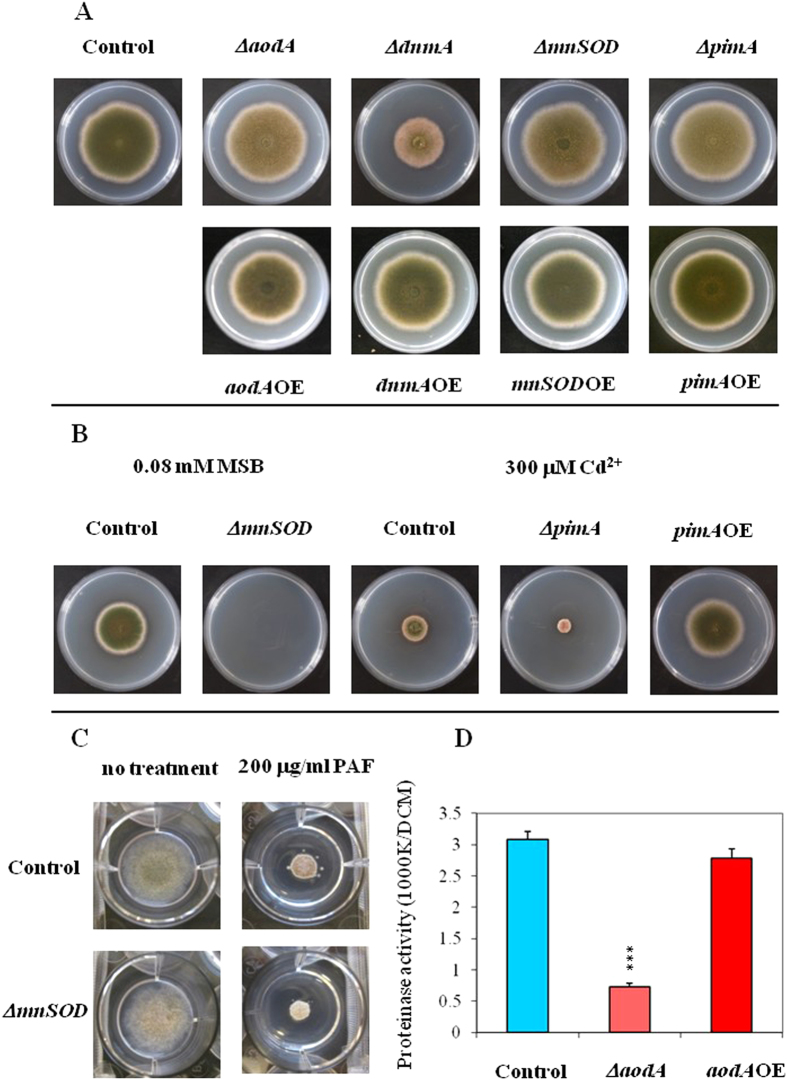
Comparison of the growth, stress sensitivities, cell death and autolysis of the control and mutant strains.Part A: Growth of control (THS30.3) and mutant strains on MNM agar plates. Part B: Selected stress sensitivity experiments with the control and the ΔmnSOD, ΔpimA and pimAOE strains. Part C: Growth inhibiting effect of the apoptosis-inducing antifungal protein PAF on the ΔmnSOD mutant in comparison to the control strain. Part D: Proteinase activities as autolysis markers2930 recorded in carbon-starving (24 h) submerged cultures of the THS30.3 control and ΔaodA and aodAOE mutants. In proteinase assays, azocasein was used as substrate, and mean ± SD proteinase activity values calculated from three independent experiments are presented. The statistically significant difference calculated for the ΔaodA strain by the Student’s t test is marked with asterisks: ***p < 0.1%. Further phenotypes were not detected as shown in Supplementary Figs S1 and S3.